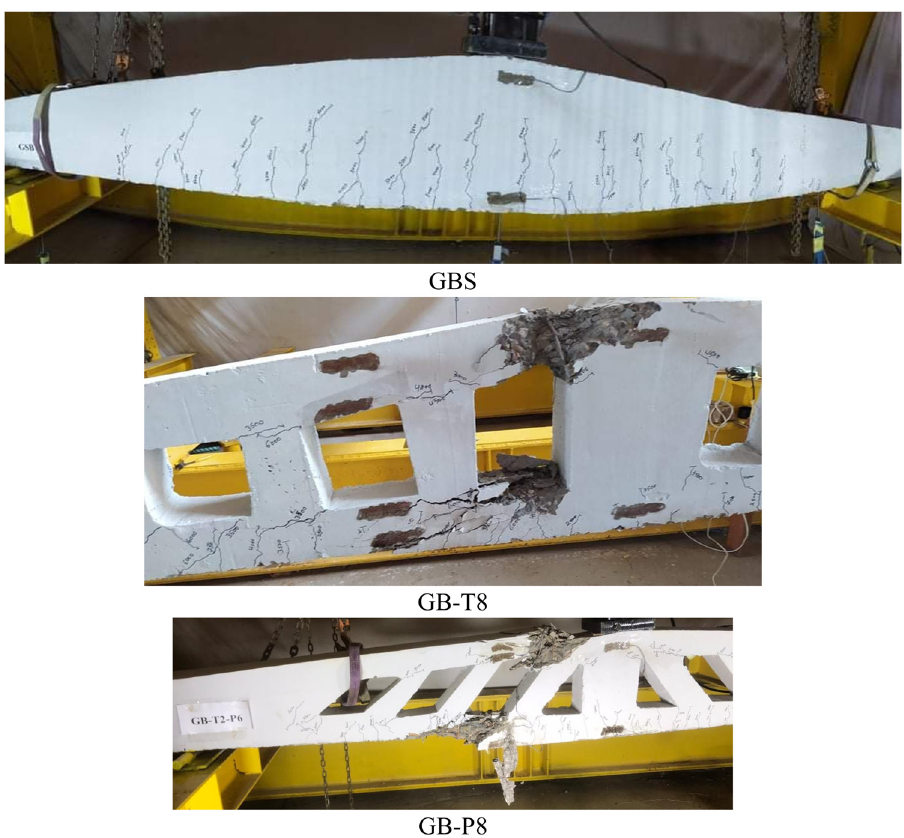
Figure 9: Failure of gable beam with openings.